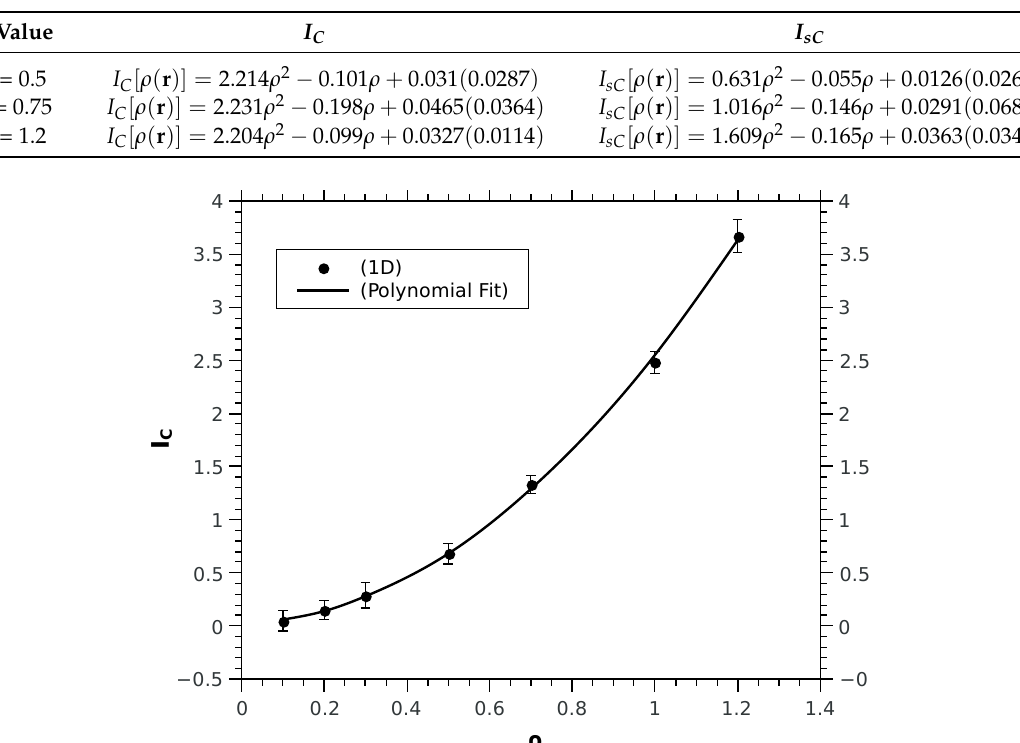
Figure 1. Computed values of I C [ ρ ( r )] for different densities in 1D obtained at optimal γ values. The analytical fit in this case is I C [ ρ ( r )] = 2.41 ρ ( r ) 2 + 0.11 ρ ( r ) + 0.025 with RMS error value 0.0165. All values are in atomic